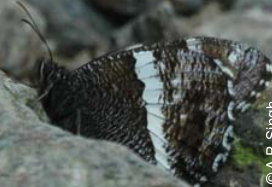
Image 87. Dark Evening Brown, Melanitis phedima (upper)